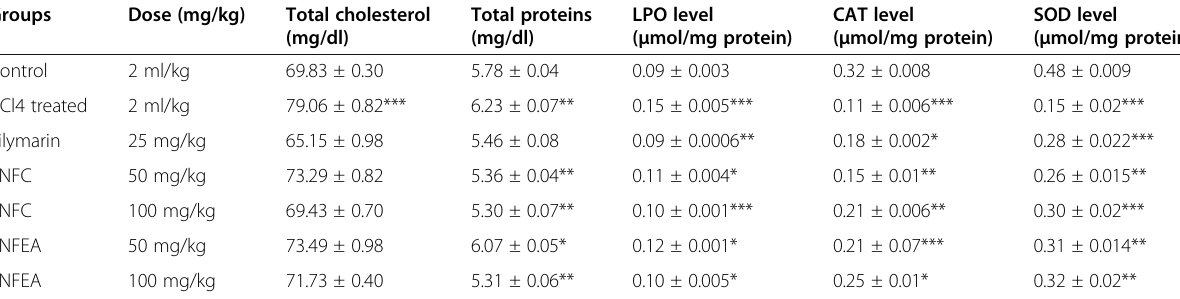
Table 3 Effect PNFC and PNFEA of fractions on total cholesterol, total proteins, LPO, CAT, and SOD in CCl 4 -induced rats